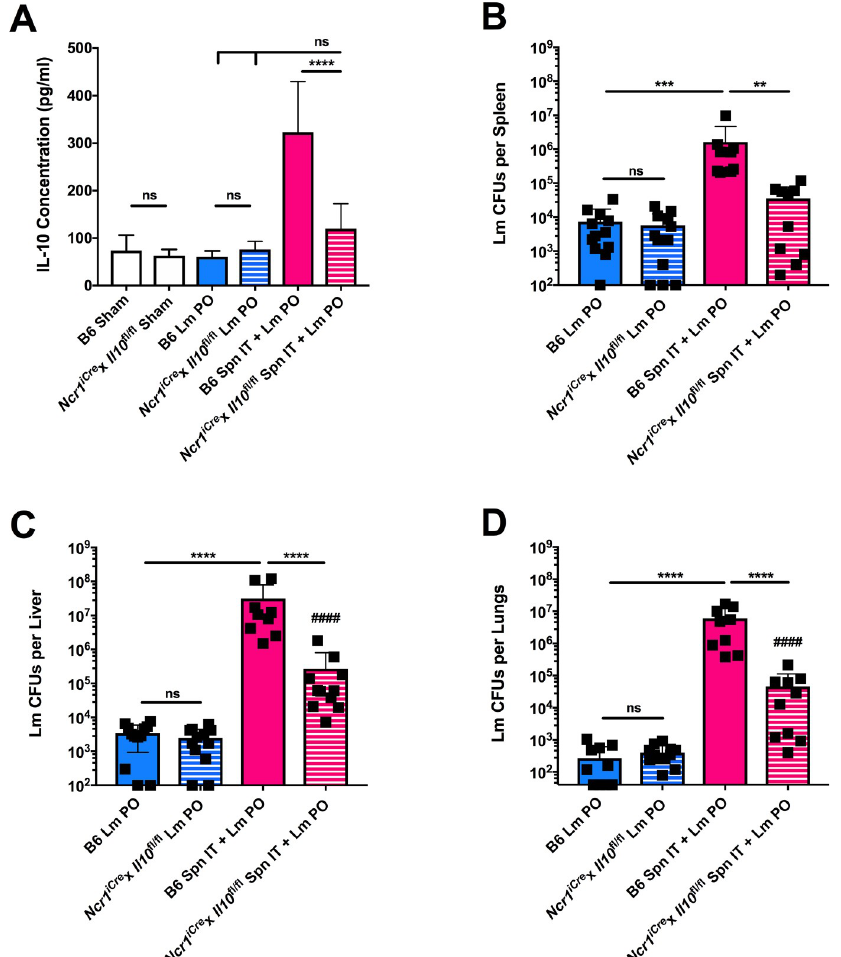
Fig 4. Exacerbated Lm burdens require the production of IL-10 by Ncr1 + cells . C57BL/6J (B6) and Ncr1 iCre x Il10 fl/fl male and female age-matched mice were infected with sham control, Lm PO, or Spn IT + Lm PO and harvested at 3 dpi. (A) Upon sacrifice, blood was collected by cardiac puncture, and serum IL-10 was measured by ELISA. Data represent mean ± SEM, One-way ANOVA, pooled from 2 experiments, 6 mice per group, ���� p < 0.0001 between indicated groups. Lm burdens were enumerated from (B) spleens, (C) livers, (D) lungs. Data represent mean ± SD, Mann-Whitney t-test, pooled from 3 experiments, 9–12 mice per group. �� p < 0.002, ��� p < 0.0002, ���� p < 0.0001 between indicated groups, ####p < 0.0001 between Ncr1 iCre x Il10 fl/f coinfected mice and B6 Lm PO infected